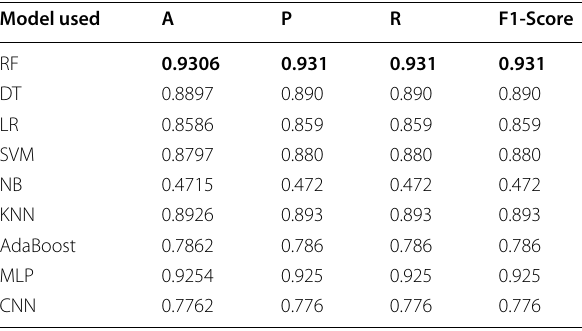
A-Accuracy, P-Precision, R-Recall, RF-Random Forest, DT-Decision Tree, LR-Logistic Regression, SVM-Support Vector Machine, NB-Naïve-Bayes, KNN-K Nearest Neighbour, MLP-Multi-Layer Perceptron The highest performance in terms of Accuracy, Precision, Recall, and F1-score are highlighted in bold